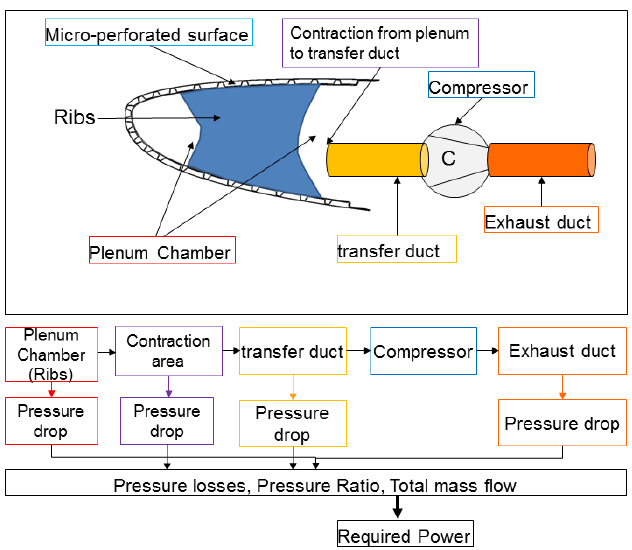
Figure 7. Schematic explaining of pressure losses and suction power estimation.